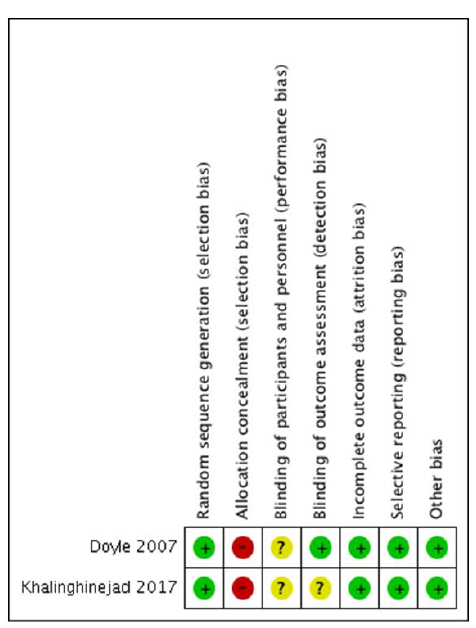
Figure 4. Risk of bias summary of included studies according the Cochrane Collaboration’s tool for assessing risk of bias. + Low risk of bias. - High risk of bias. ? Unclear risk of bias.